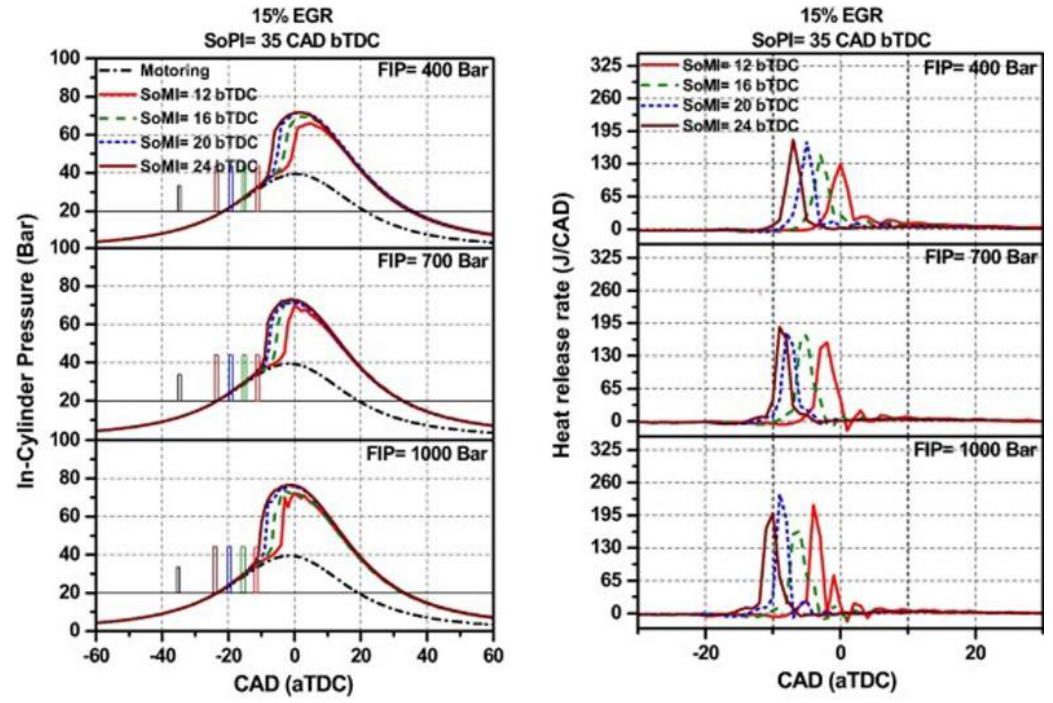
Figure 4. In-cylinder pressure and HRR variations with crank angle at di ff erent fuel injection pressures (FIP)